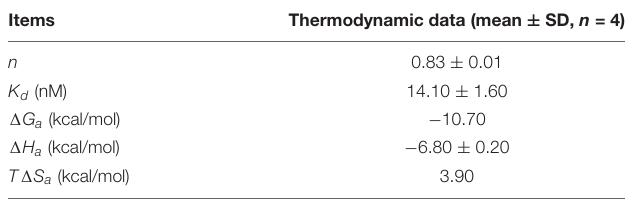
TABLE 2 | Data collection and refinement statistics of Hsp90 N -SNX-2112 complex